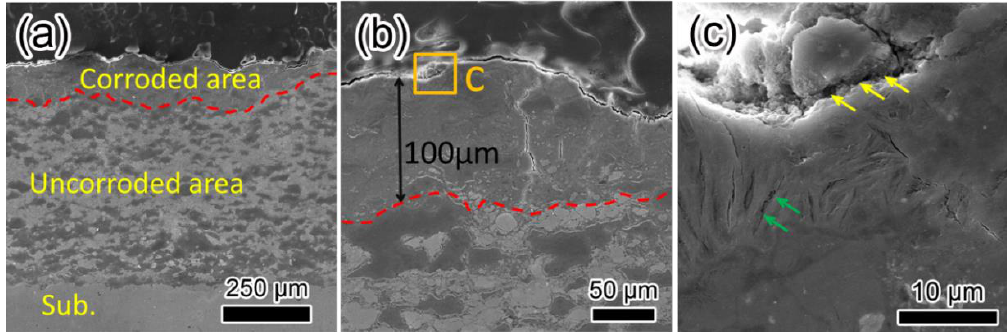
Figure 5. The SEM images of cross-section micrographs of the coating after 200 days of the salt spray corrosion test at ( a ) 250×; ( b ) 500× and ( c ) 3000× magnification.